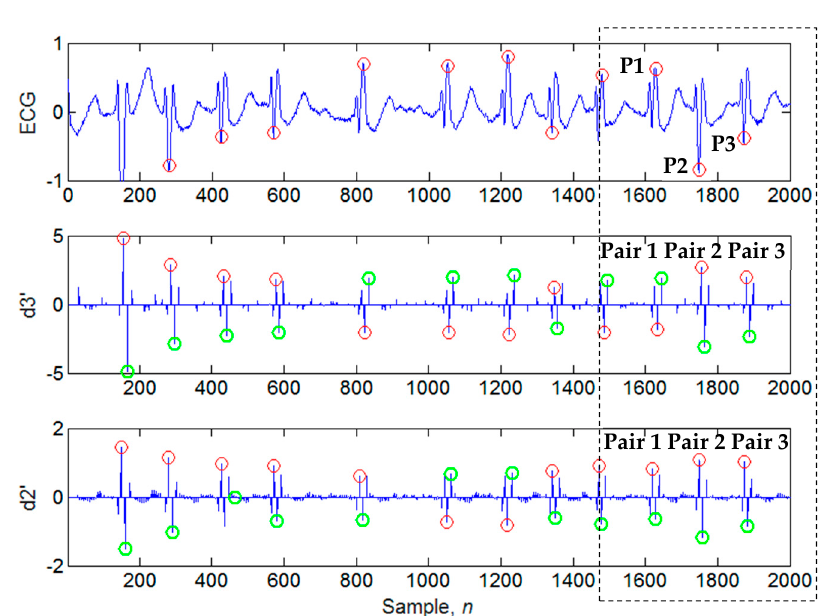
Figure 10. Illustration of the identifications of QRS peaks for Case 2.1.